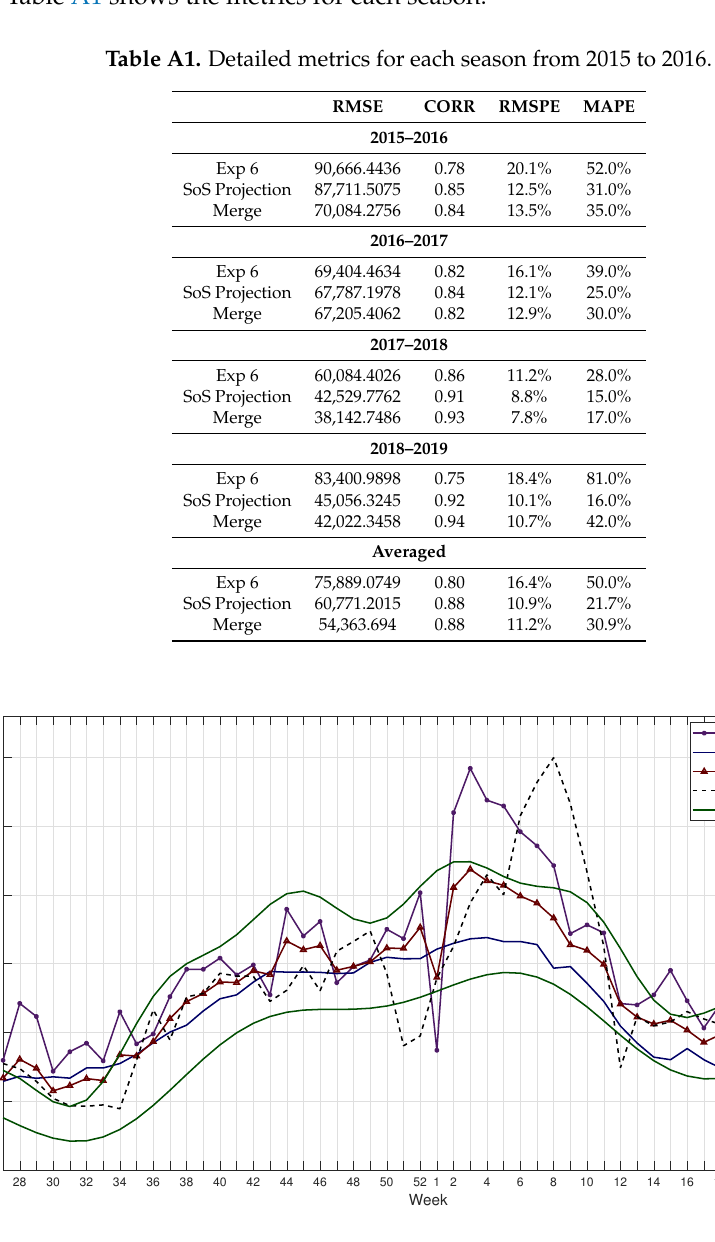
Figure A1. Results from the model for the year 2015–2016 compared with the real values for ARI